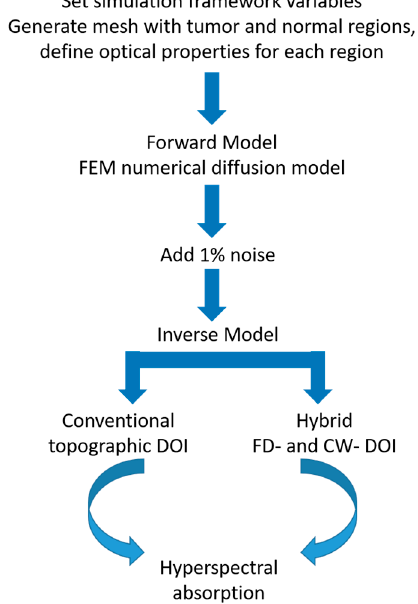
Figure 2. Simulation framework.